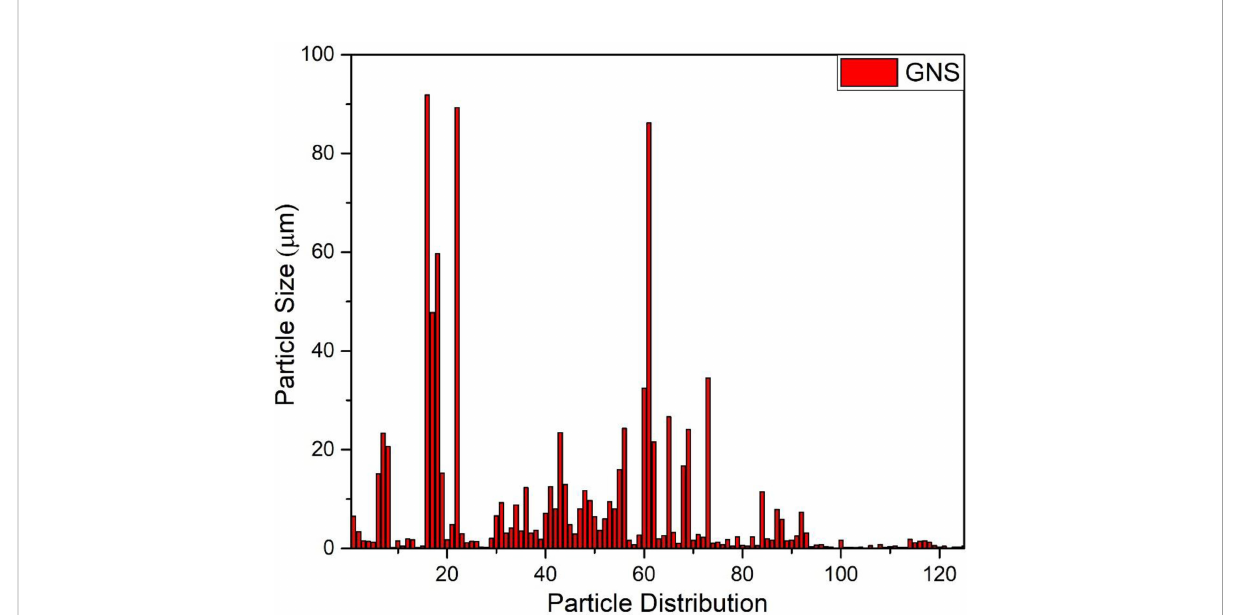
FIGURE 6 Graphical representation of particles distribution size of green synthesized graphene oxide nanoparticles.